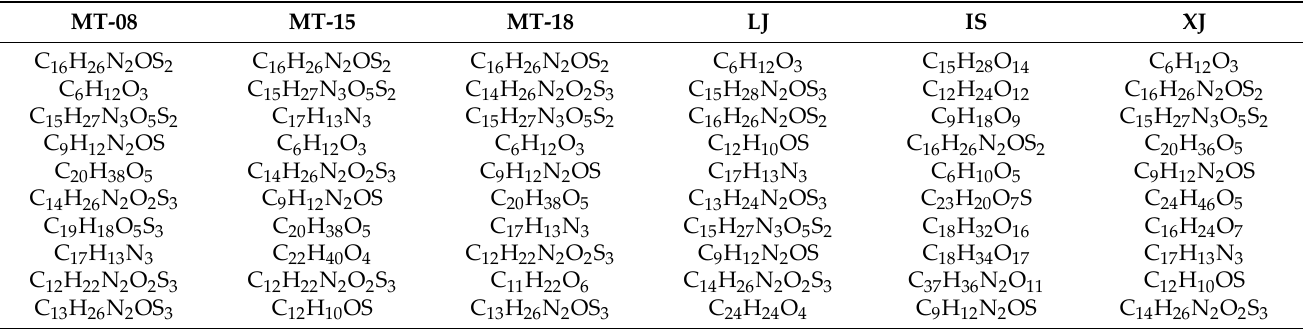
Table 3. Specific molecular formulas with the top 10 abundance in different Baijiu samples.